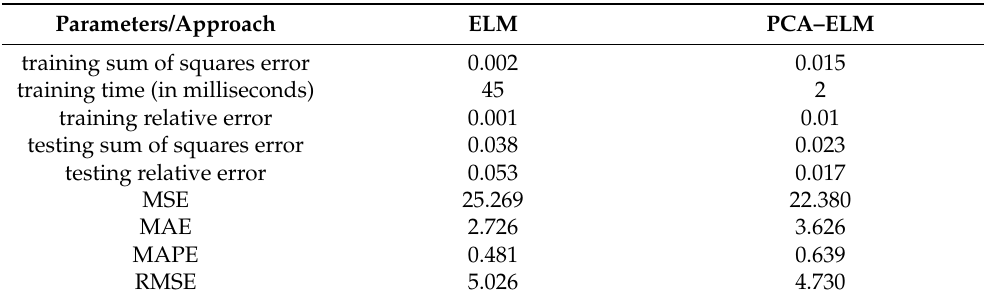
Table 3. ELM model and PCA–ELM integration model using a sigmoid activation function with 100 hidden